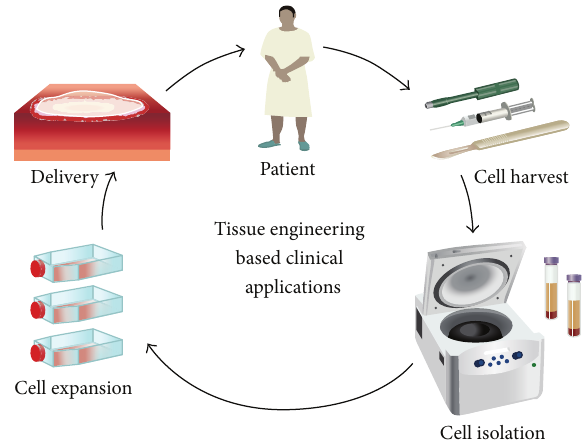
Figure 5: Work flow of cell-based regenerative therapy. An ideal regenerative medicine strategy requires three components: an ideal cell type, biomimetic scaffold, and factors to create the desired biological response in vivo . Cutaneous wounds represent a harsh environment for cellular therapy due to their hypoxic environment and low pH which can affect the survival and potential of transplanted cells. The niche microenvironment can be manipulated with the use of scaffolds and growth factors to enhance cellular survival, promote cellular differentiation, and ultimately enhance wound healing in the clinical setting. Reproduced with permission from the authors: McArdle, Paik, Chung, Hu, and Walmsley et al. (2013) Manipulation of Stem Cells and their Microenvironment for Tissue Engineering. Surgery Curr Res